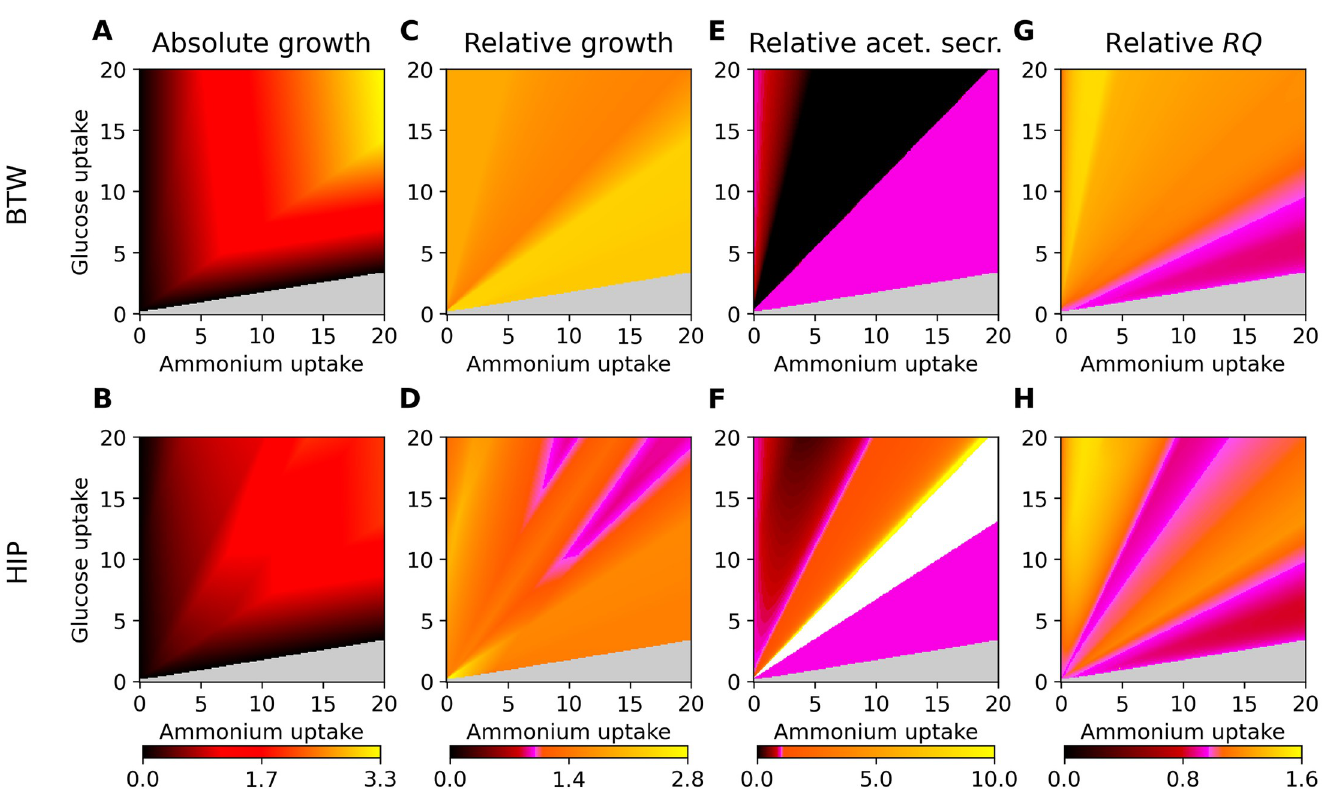
Fig 3. Side-by-side comparison of the BTW and HIP method, panels C-H are relative to the respective panels (and uptake rates therein) in Fig 1 of the unlimited environment UL. Glucose and nitrogen were fixed to the given uptake rates, all other uptakes are unconstrained. Note that a specific BOF for each coordinate was generated using HIP, as it in contrast to BTW depends on the environment. Non-growth areas are in light grey, a value of unity is indicated by pink. Panels A and B show growth phenotype phase-planes, panels C and D show relative growth phenotype phase-planes with the UL BOF as reference. Panels E and F show acetate secretion flux rates relative to those of the UL BOF, and G and H show the respiratory quotient RQ relative to the UL BOF RQ . The white area in the relative acetate secretion plot for the HIP method indicates a small acetate production in HIP, and zero acetate production in the UL BOF. Note that the growth rates are in h − 1 gCDW − 1 , the relative panels are